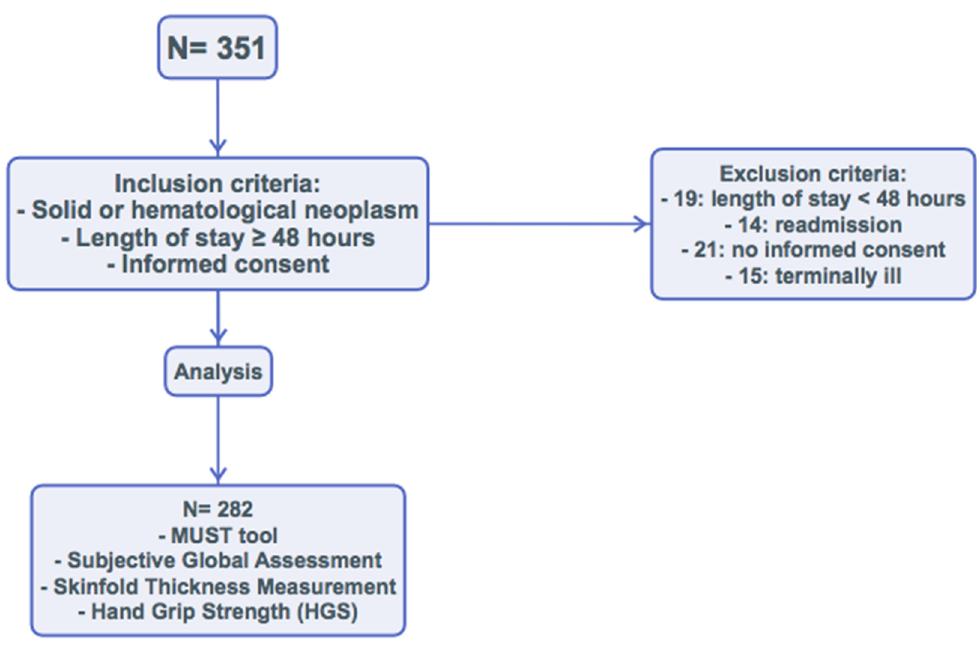
Figure 1. Flow Figure 1. Flow chart.